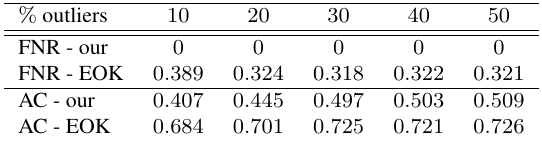
Table 2: Outlier detection: false negative rate (FNR) and accu- racy (AC) of the classification in the case p = 0 . 5 .